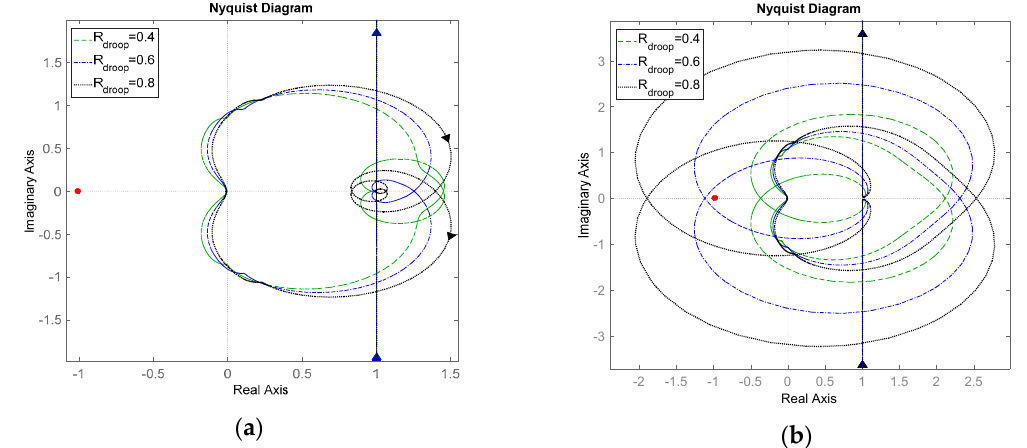
Figure 13. Comparative stability analysis result of the studied dc microgrid system with droop coefficient variations. ( a ) Proposed NDOB-VNI stabilizing strategy controlled system; ( b ) Conventional droop controlled system.